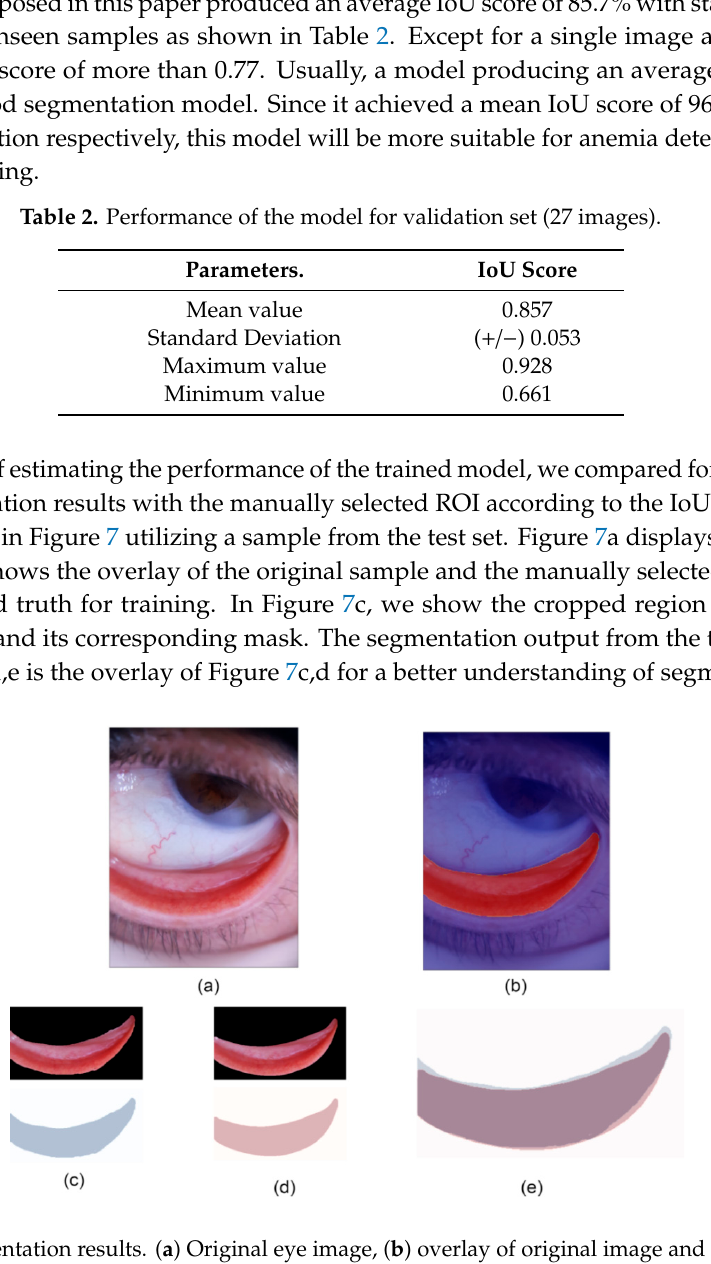
Figure 7. Segmentation results. ( a ) Original eye image, ( b ) overlay of original image and ground truth, ( c ) manually segmented region of interest (ROI) and its mask, ( d ) segmentation of ROI by the model and its mask, ( e ) overlay of ‘d’ and ‘e’ (IoU score =